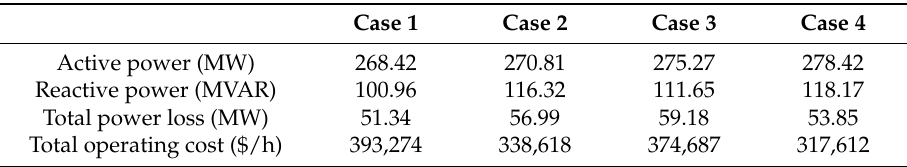
Table 3. Detailed results for each case in the modified IEEE-14 bus system.